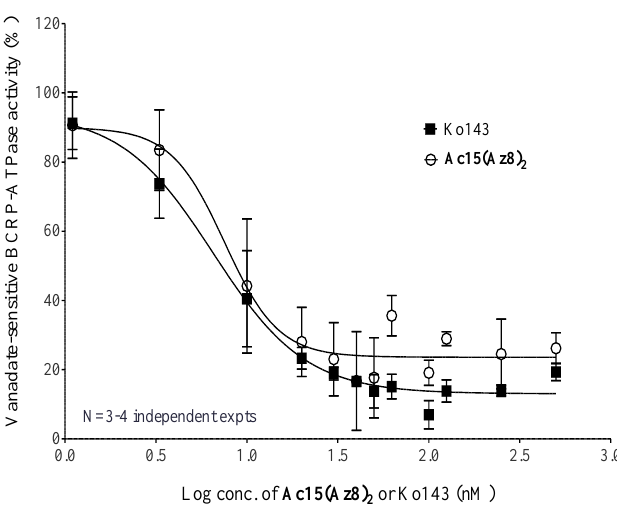
Figure 6. Effect of Ac15(Az8) 2 on vanadate-sensitive BCRP-ATPase activity. Ouabain (Na + /K + - ATPase inhibitor) and sodium azide (F-type ATPase inhibitor) were added to S1M180 microsome fraction to inhibit non-ABC transporter ATPase activities. Sodium orthovanadate inhibits ABC transporter ATPase activity and is used to calculate vanadate - sensitive activity by subtraction from the total ATPase activity (without sodium orthovanadate). S1M180 microsome fractions were pre-incubated with different doses of Ac15(Az8) 2 or Ko143 in the presence or absence of sodium orthovanadate at 37 °C for 30 min, followed by 1-h incubation of 2.5 mM ATP. After reaction was stopped, inorganic phosphate level was determined using colorimetry method. The percentages of vanadate-sensitive BCRP-ATPase activity were shown as mean ± S.D.